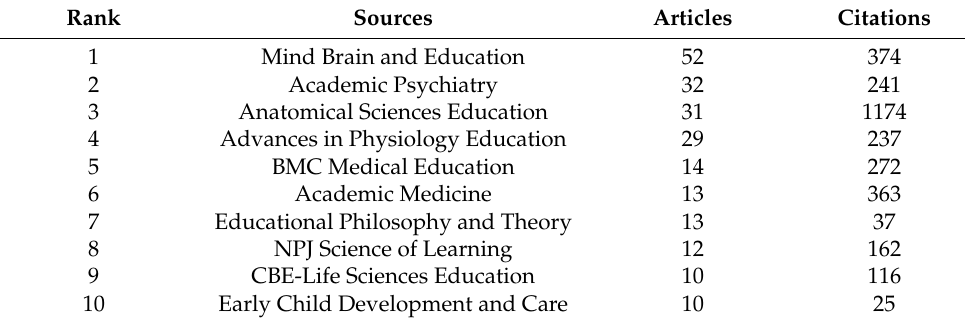
Table 7. Top 10 most influential journals.